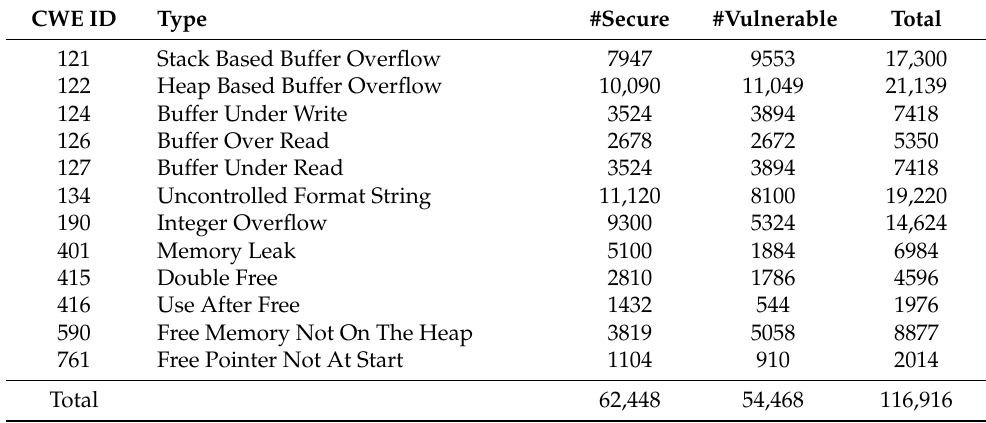
Table 3. Types of CWE.